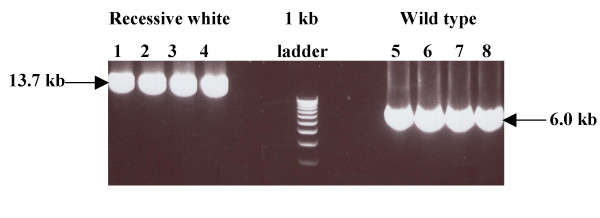
Long-range PCR amplification of intron 4 in recessive white and wild type chickens. The size of intron 4 of the TYR gene is 13.7 kb in the recessive white (left) and 6.0 kb in the wild type chicken (right).